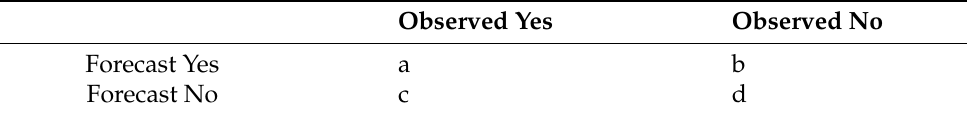
Table 1. Contingency table displaying categories of how forecasts compare to observed